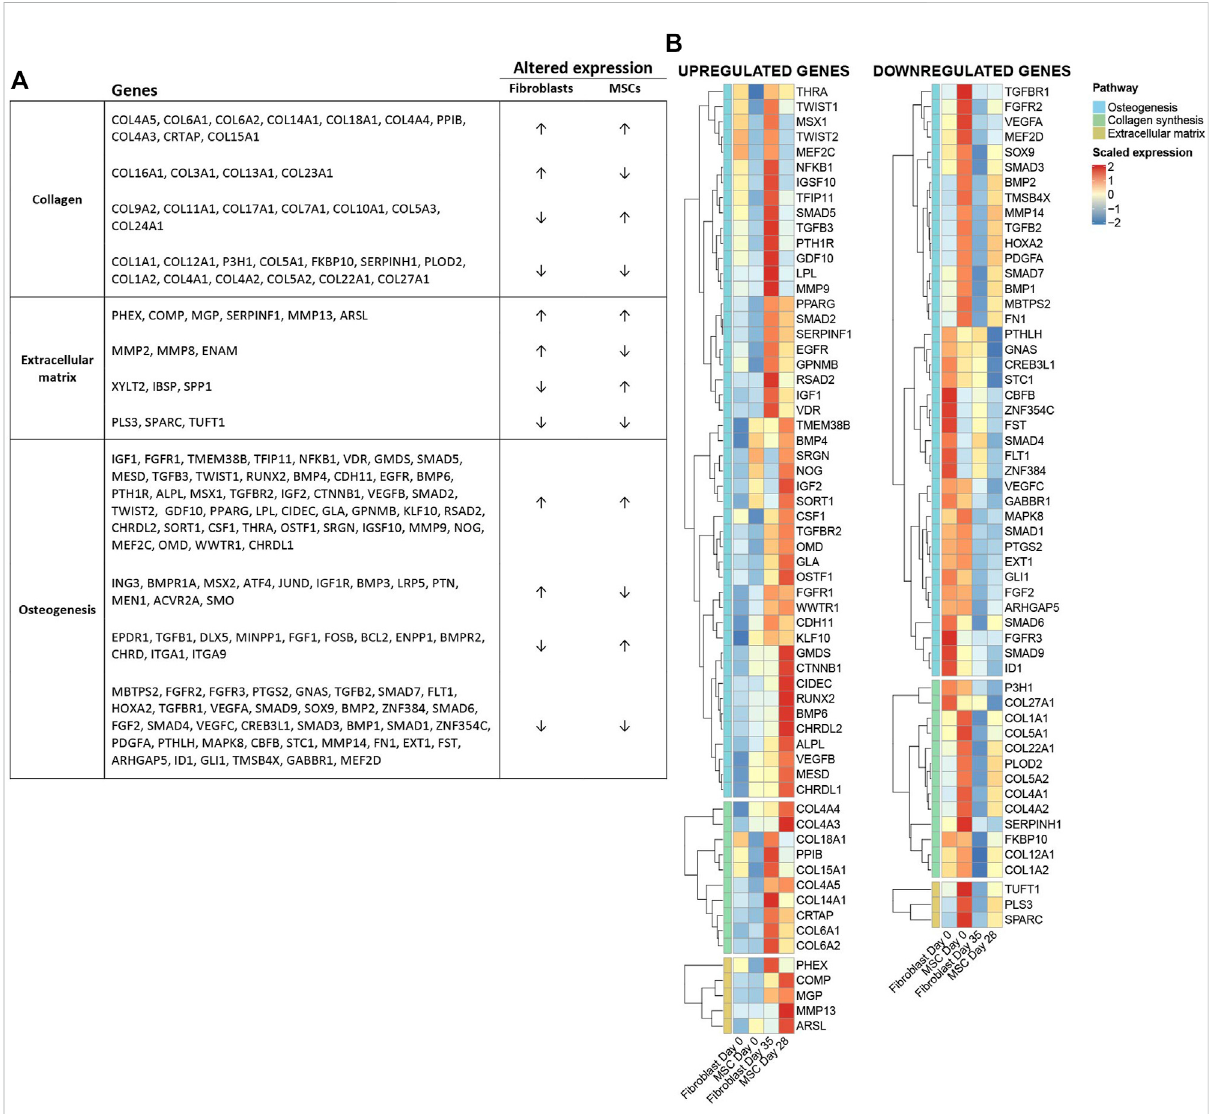
FIGURE 9 Genepro fi leofknownosteogenesis-linkedgenesduringosteoblasticdifferentiationtreatment. (A) Listof158genesdividedintothreeessential classes of bone development: collagen genes, extracellular matrix genes and osteogenesis genes. Overall, 62 genes were up-regulated in both cell types ( ↑↑ ),41 geneswere altered differently betweenthecellstypes( ↑↓ or ↓↑ )and55 genesweredown-regulated ( ↓↓ )inbothcell types from the fi rst to the last time point during the osteoblastic differentiation treatment. (B) The 62 up-regulated genes and the 55 down-regulated genes are illustrated in two heat maps. The heat maps are clustered according to the three above-mentioned classes. RNA dataset fi ltering and normalization performed with DESeq2 R package; differential expression analysis (DEA) and statistics performed in R using the limma package. Log2FC per gene was calculated based on the group means. Statistical signi fi cance of genes was determined by adjusted p -value cutoff p_adj. < 0.05 (using Benjamini – Hochberg FDR